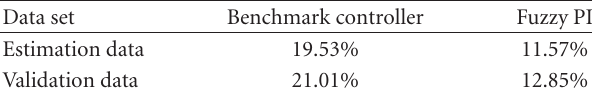
Table 2: Controllers in full load operation : NSSE%